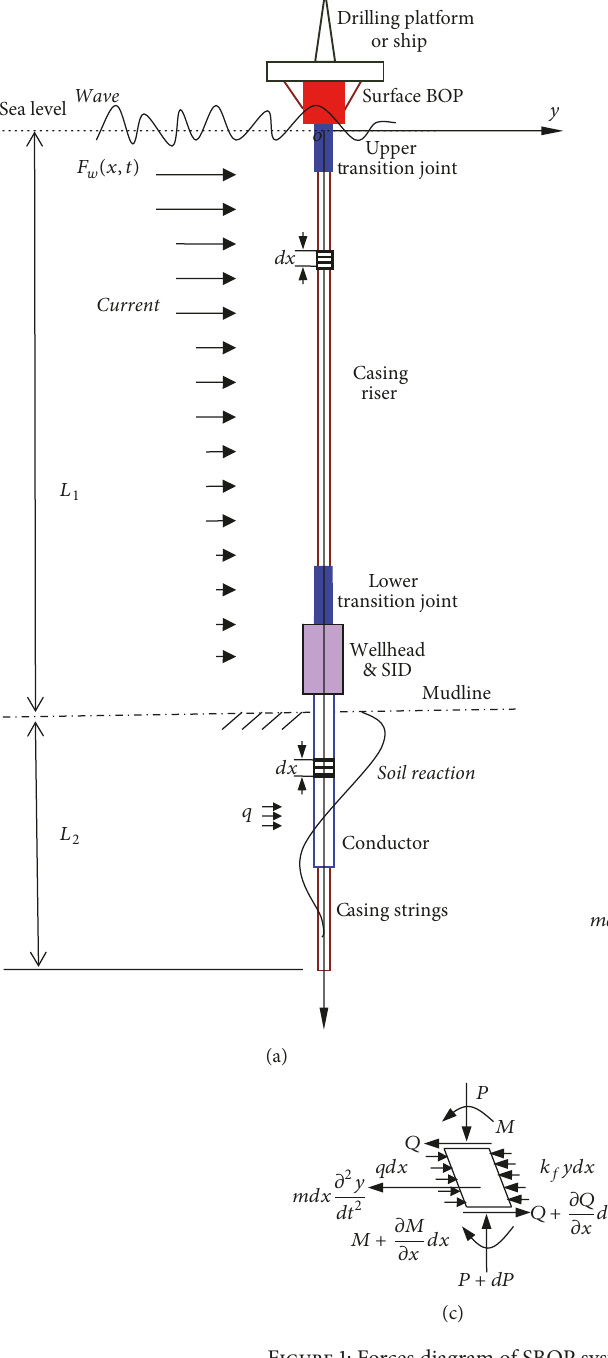
Figure 1: Forces diagram of SBOP